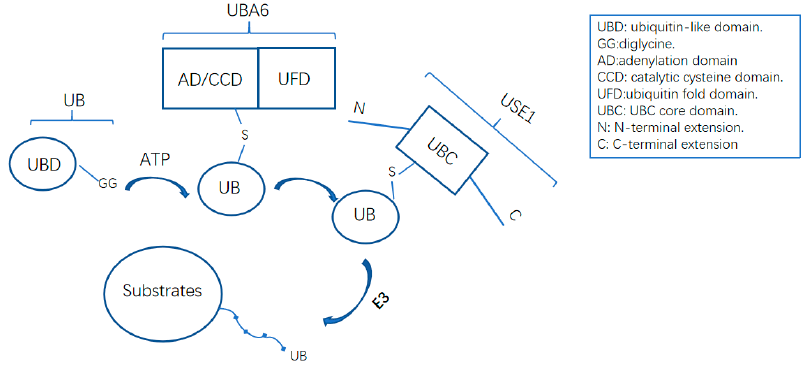
Figure 2. The activation of ubiquitin by UBA6–USE1 cascade. Ubiquitin forms a thioester bond